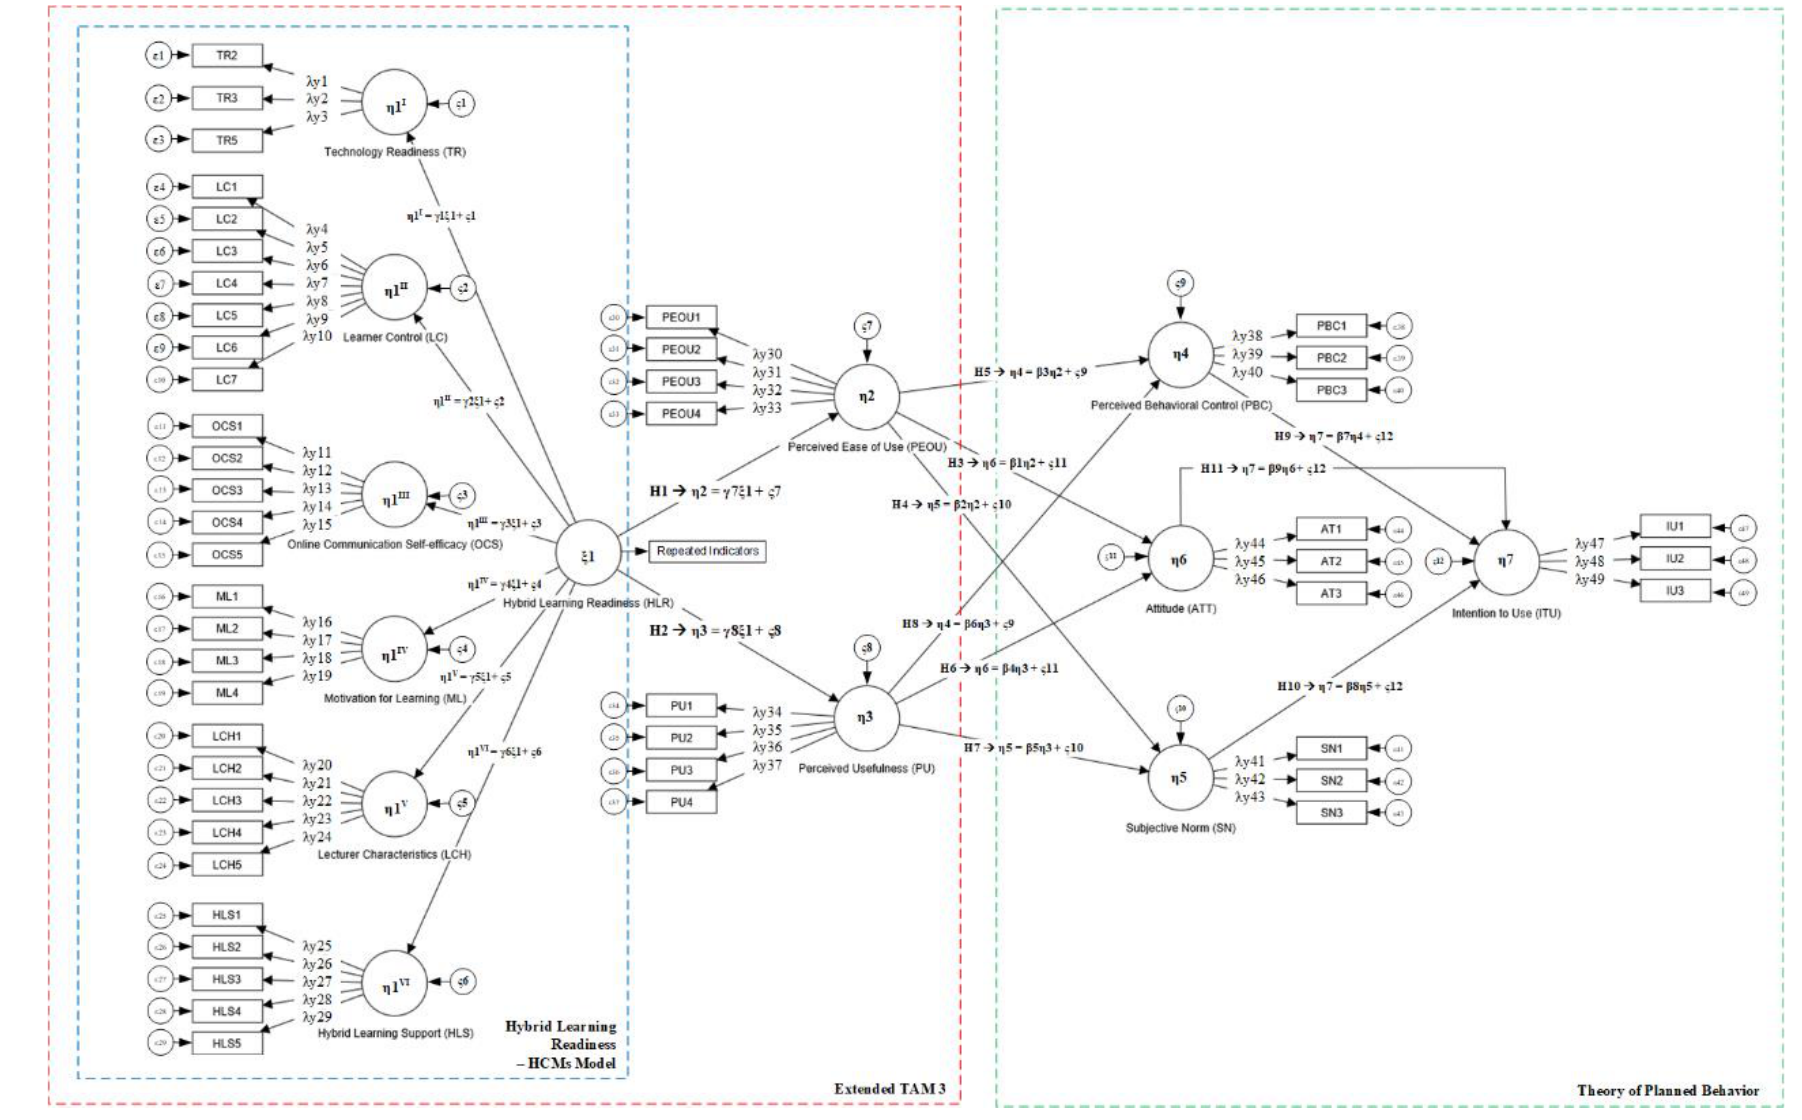
Figure 3: Conceptual Model of the Study; Source: